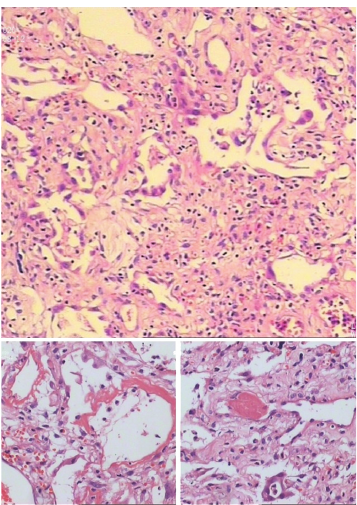
Figure 3: Lung biopsy reveals scattered hyaline membranes lining alveolar septa that are thickened by interstitial edema and inflam- matory cell infiltration besides hyperplasia of type II